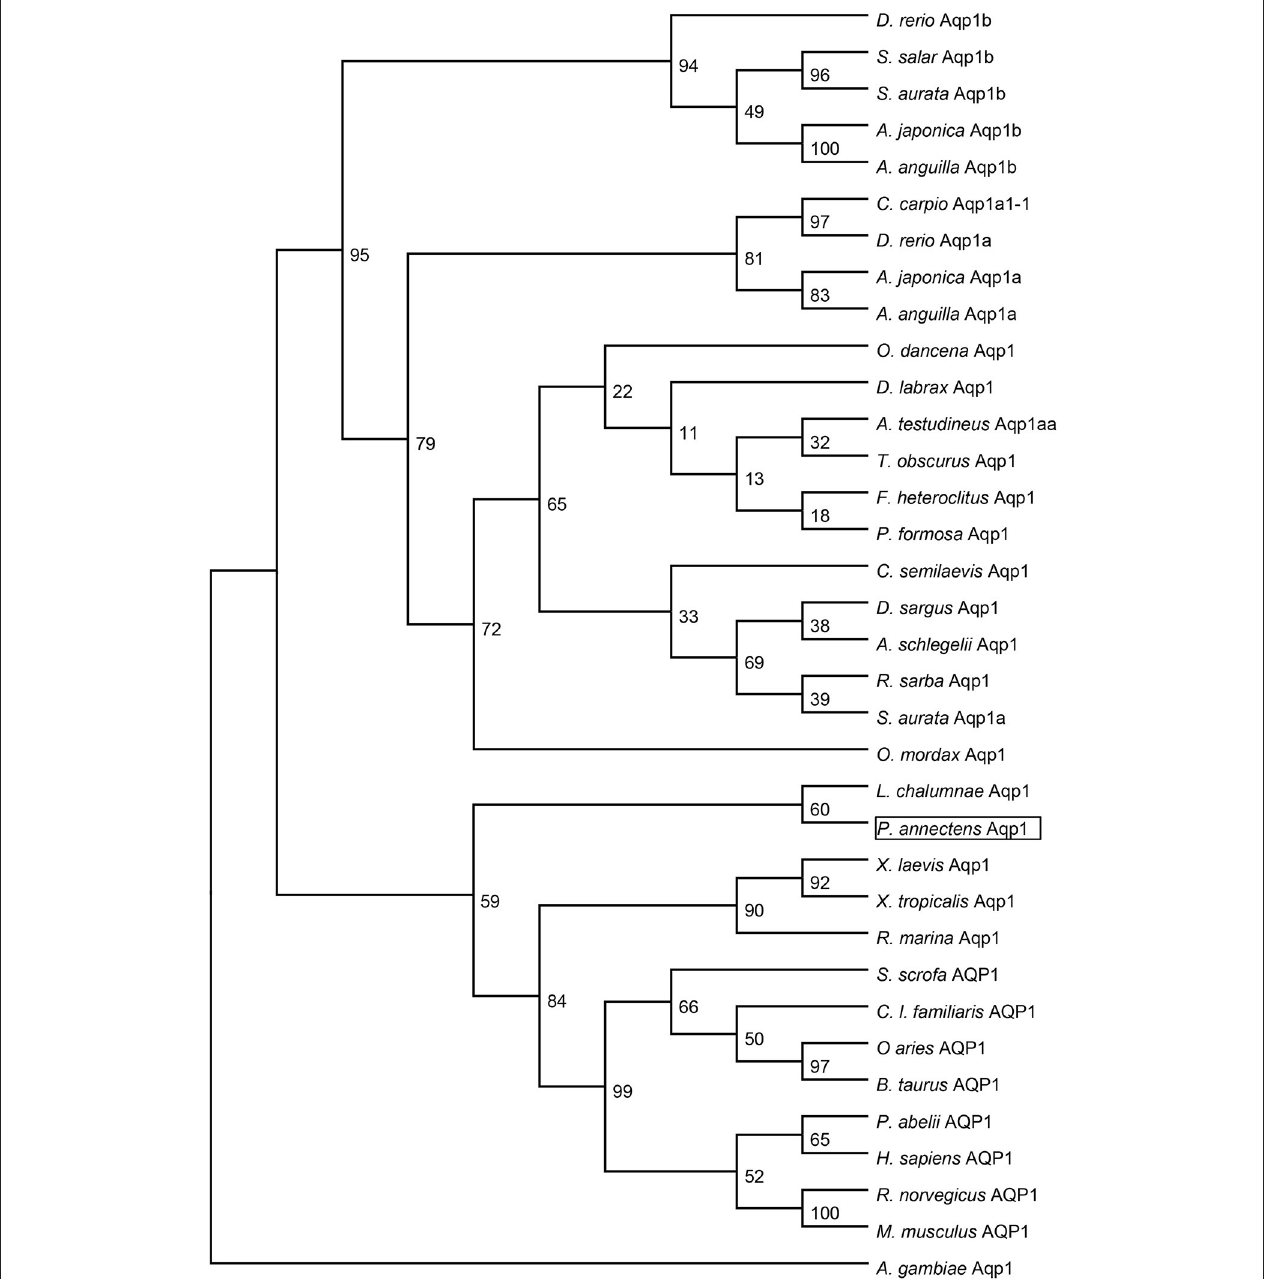
FIGURE 3 | A dendrogram of aquaporin 1 (Aqp1/AQP1) including Aqp1 of Protopterus annectens . The support for nodes is indicated by % bootstrap support (out of 1000) in the maximum likelihood analysis, employing the LG (Le and Gascuel, 2008) model of amino acid substitution. Anopheles gambiae Aqp1 is used as outgroup for the